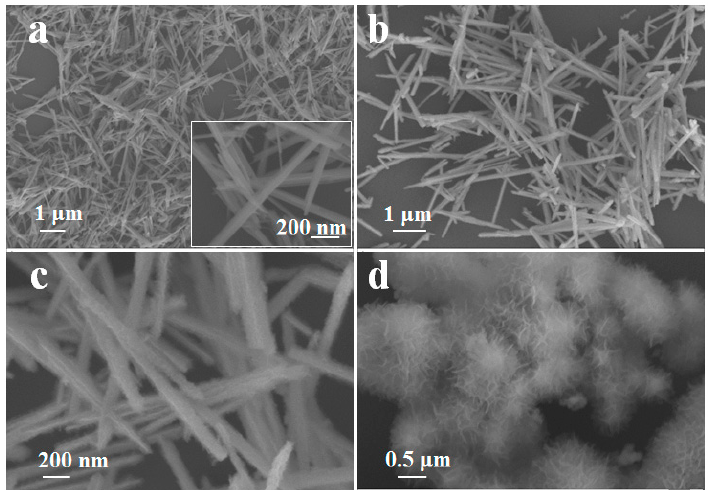
Figure 2. SEM images of: ( a ) α -MnO 2 needles; ( b , c ) MnO 2 @MnO 2 ; and ( d ) amorphous MnO 2 .